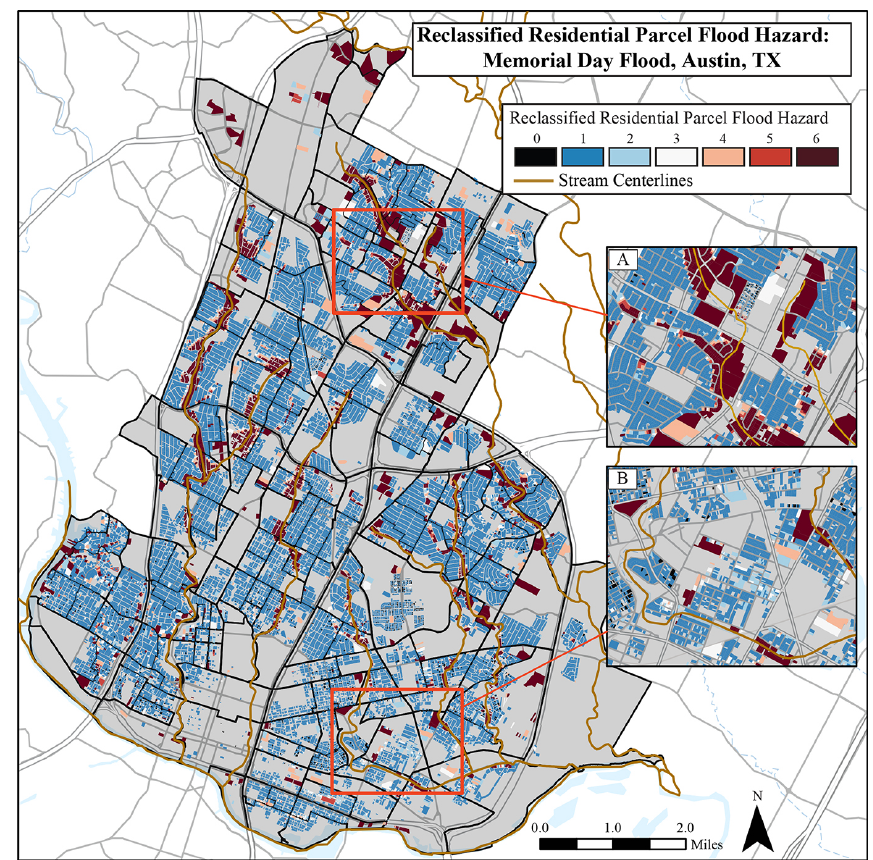
Figure 7. Reclassified residential flood hazard during the 2015 Memorial Day flood in Austin,